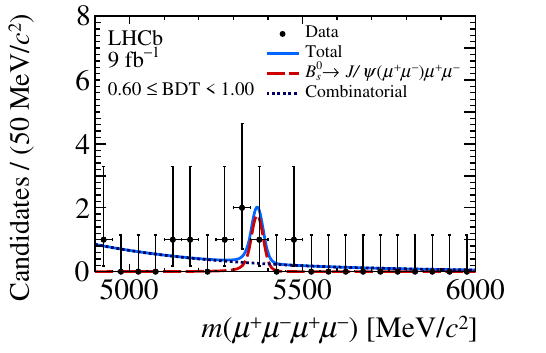
→ J/ψ ( µ + µ − ) µ + µ − and (right) s